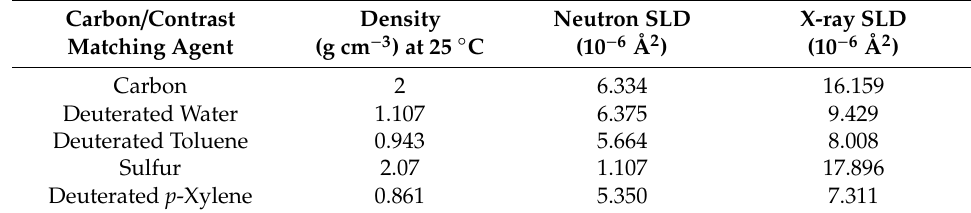
Table 2. The neutron and X-ray scattering length densities [74].